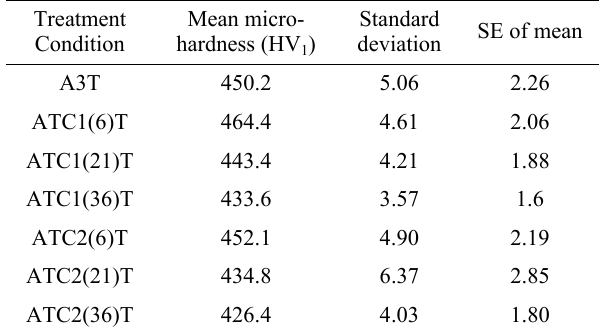
Table 4 Mean micro-hardness of CHT and varied cryogenic treated samples.